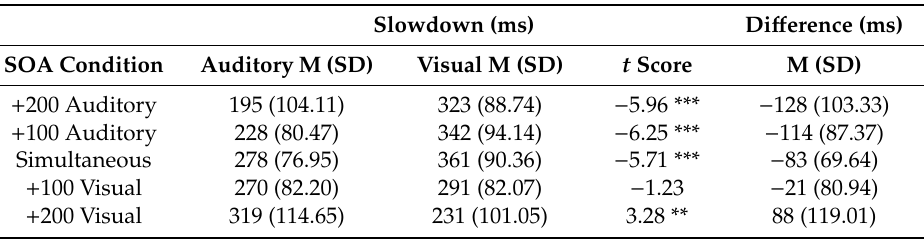
Table 5. Visual dominance scores in the 3-button task. Means and standard deviations, and t statistics from pairwise comparisons of slowdown scores for auditory and visual oddballs. Means and standard deviations of visual dominance scores; negative values indicate auditory dominance and positive values indicate visual dominance.